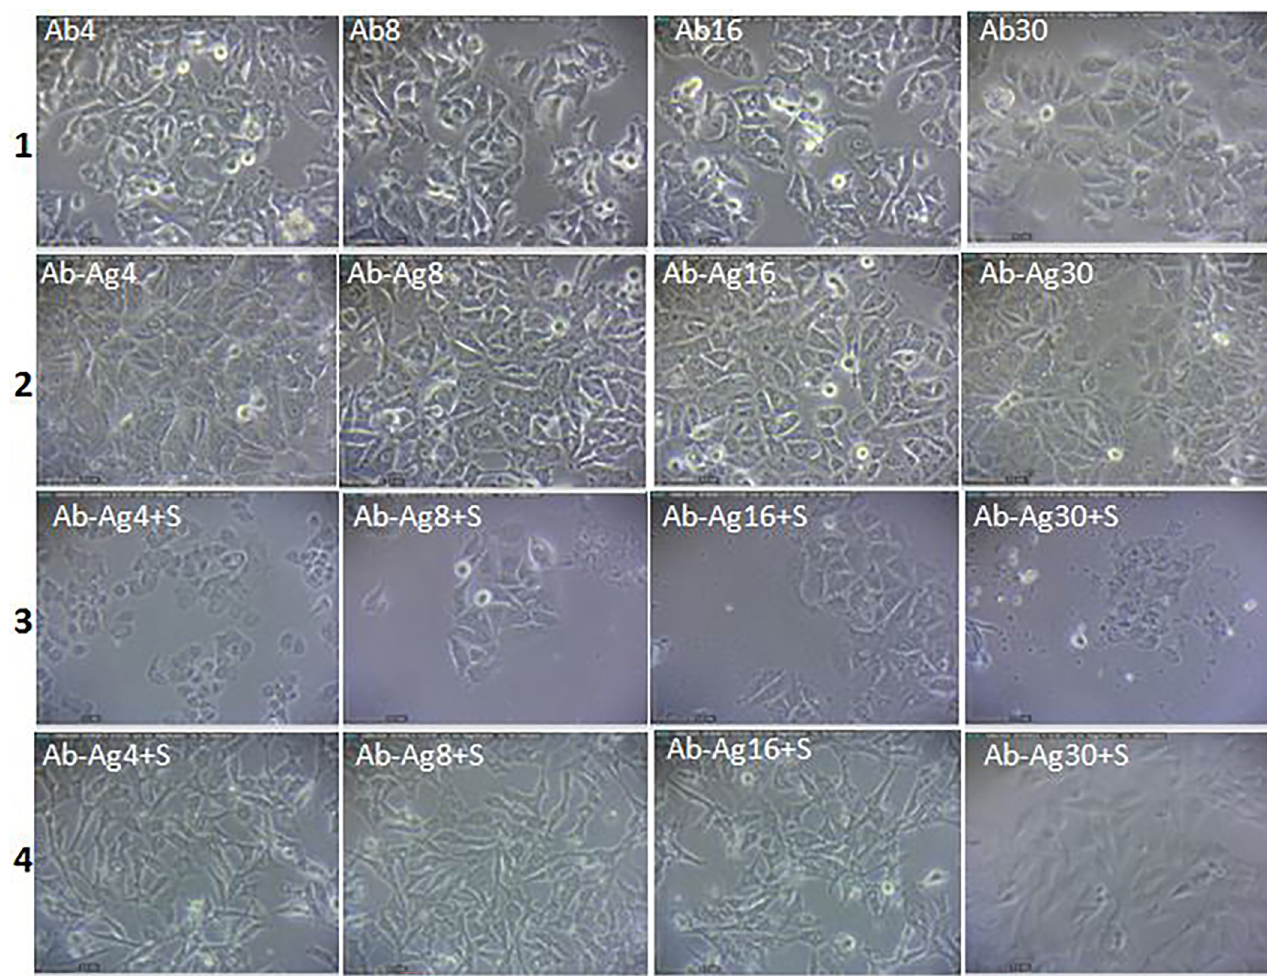
Fig 3. The effects of different concentrations (4, 8, 16 and 30 μ g) of the specific antibody (Ab), antibody conjugated to E . coli antigens (Ab-Ag) and antibody conjugated to E . coli antigens associated with active serum (Ab-Ag+S) on morphology of MCF7 (row 1, 2 and 3) and HUVEC cell lines (row 4).